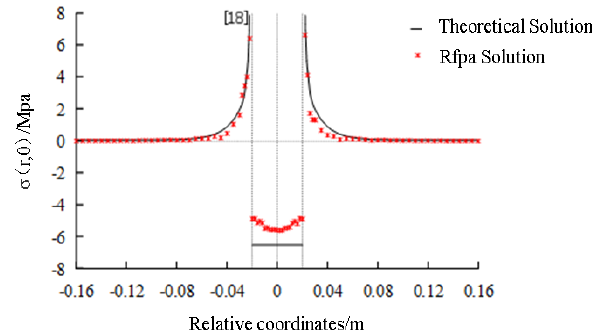
Figure 12. Comparative analysis of the minimum principal stress numerical and analytical solutions at ξ = 0.06.